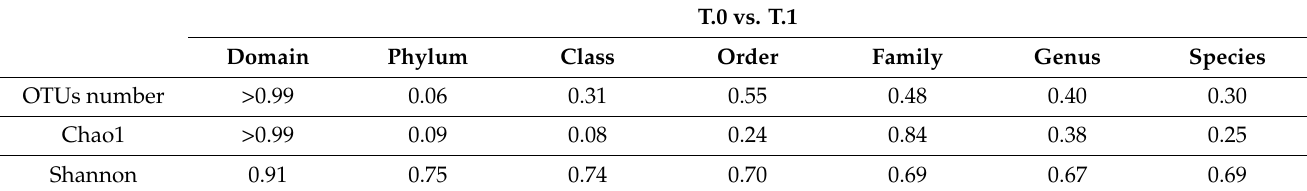
Table 1. Statistical comparison between the alpha diversity indexes of T.0 and T.1 microbiotas at all taxonomic levels (Welch’s t -test and Kolmogorov–Smirnov test, both with p ≤ 0.05). T.0 vs.